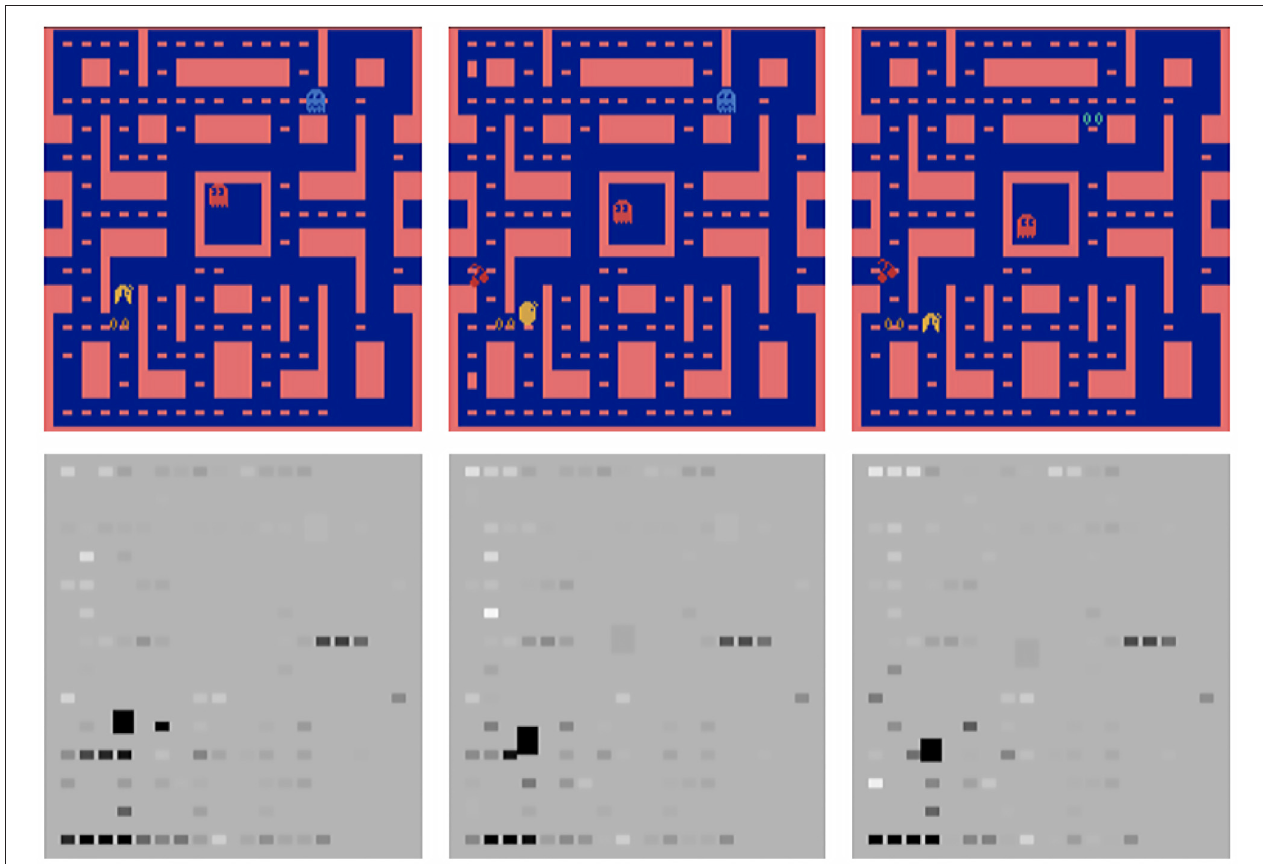
FIGURE 7 | Screenshots (left) and their matching object saliency maps (right) in the game Ms Pacman (from Iyer et al., 2018, p. 148, reproduced with permission).